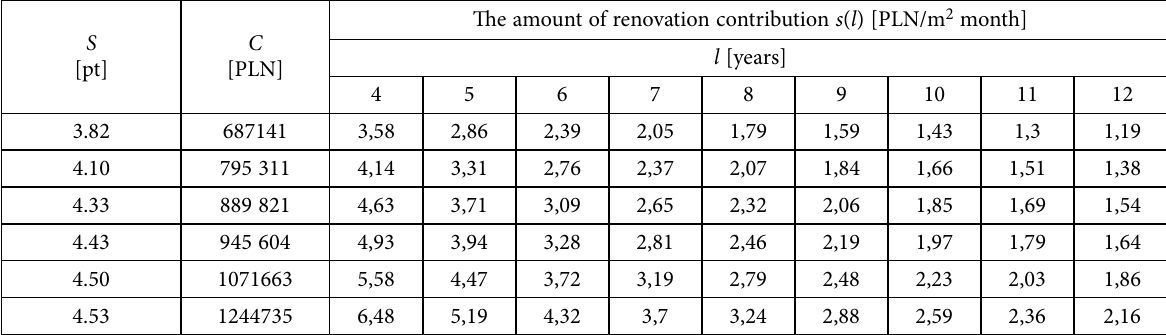
Table 6. Variants of the amount of renovation contribution s ( l ) in the years, for the value of the building condition index S The amount of renovation contribution s ( l ) [PLN/m 2 S [pt] [PLN]